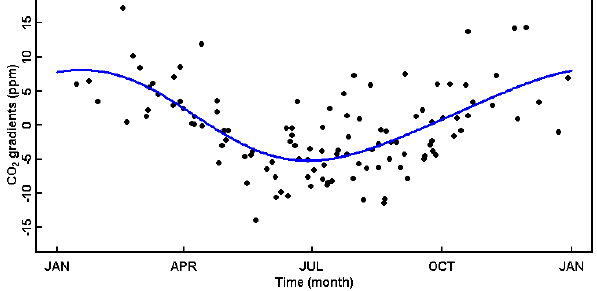
Fig. 12. Seasonal cycle of CO 2 gradients (300m minus 2500m); a third-order harmonic function is fitted to these data (the blue spline).